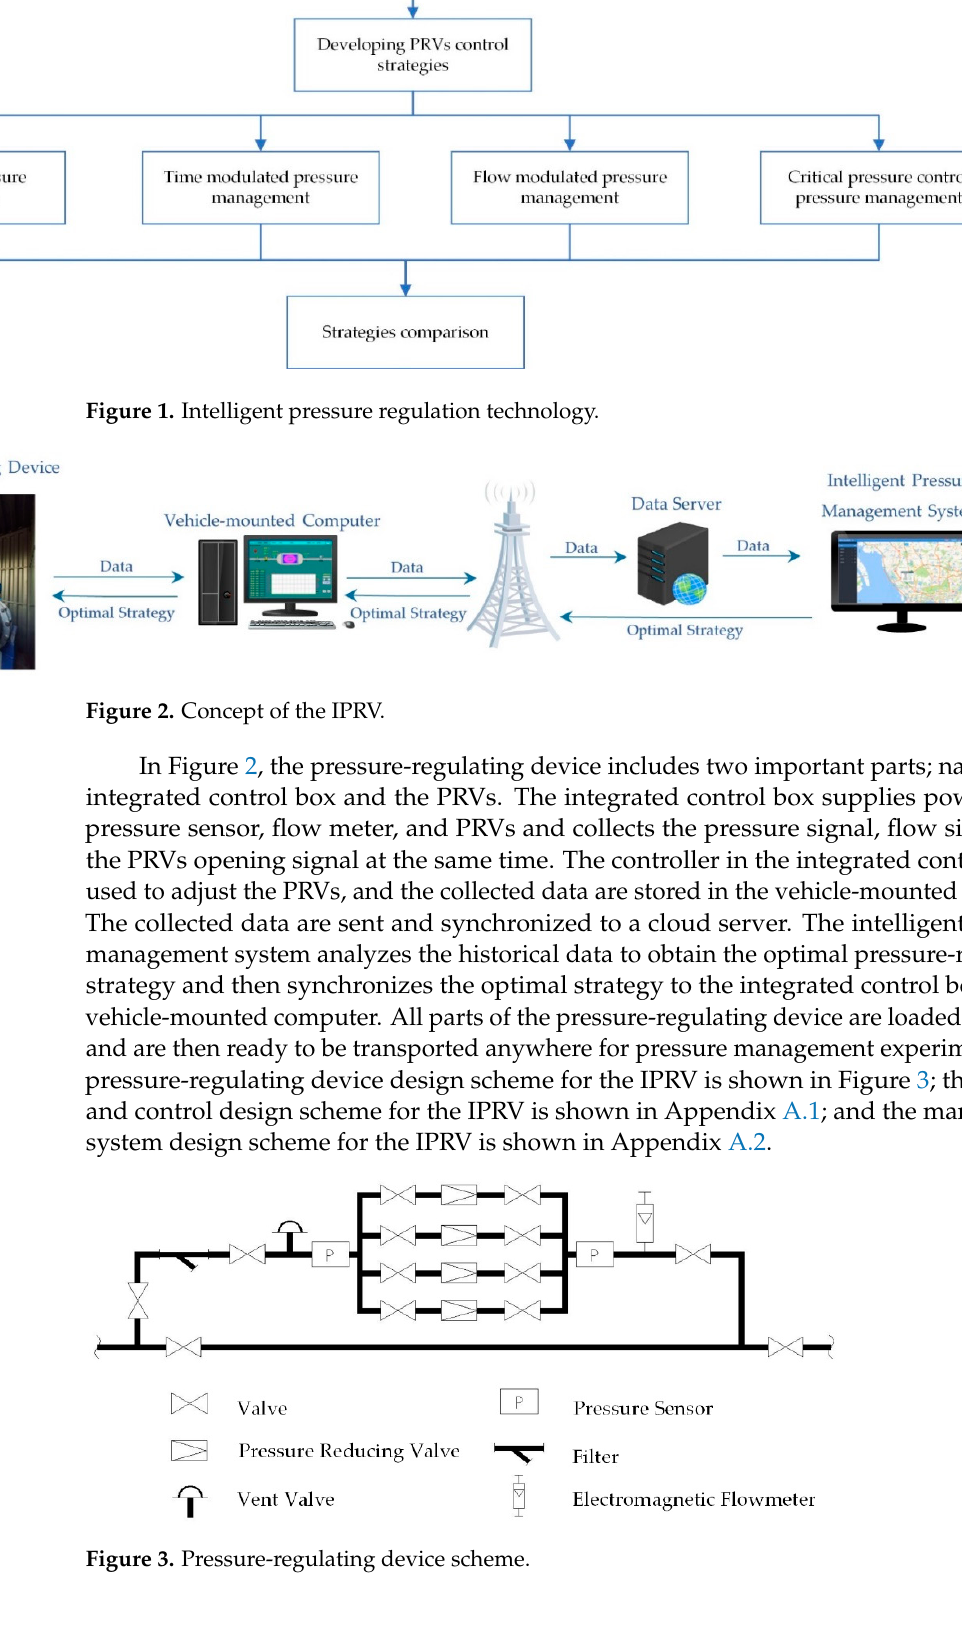
Figure 1. Intelligent pressure regulation technology .